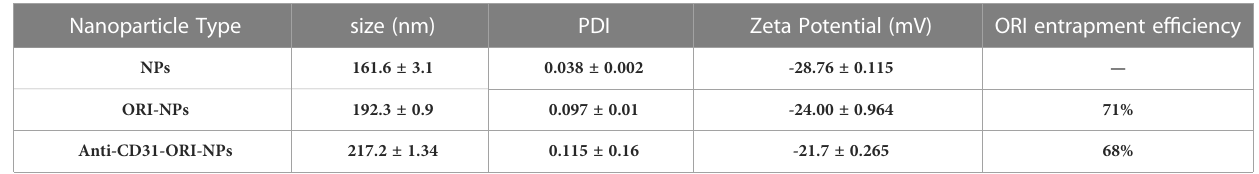
TABLE 1 Characterization of the NPs.